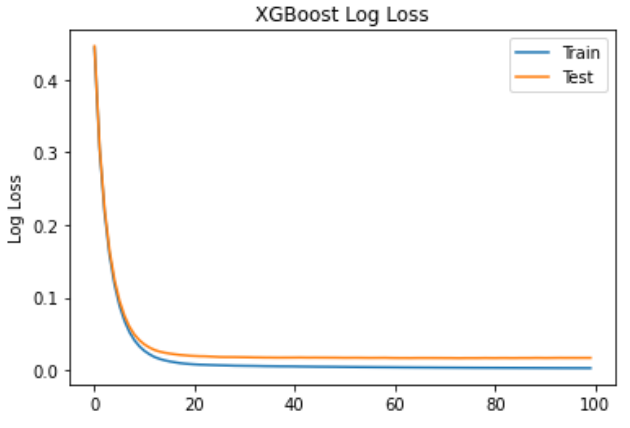
Figure 4. Logloss of XGboost.